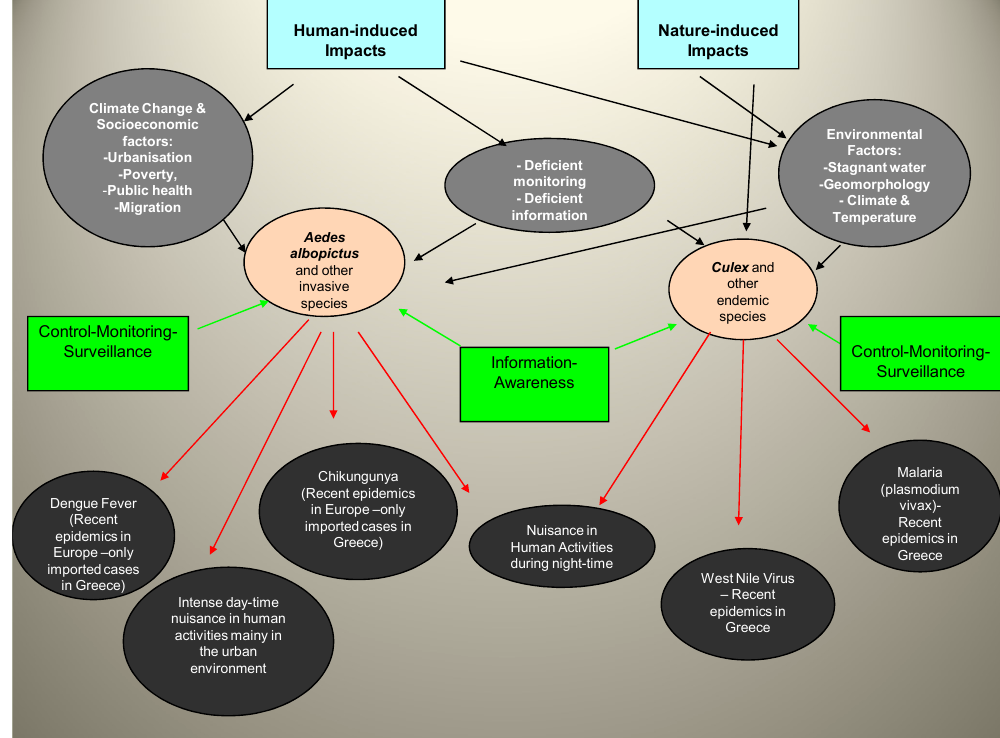
Figure 1. The invasive mosquito species and endemic mosquitoes impact model.